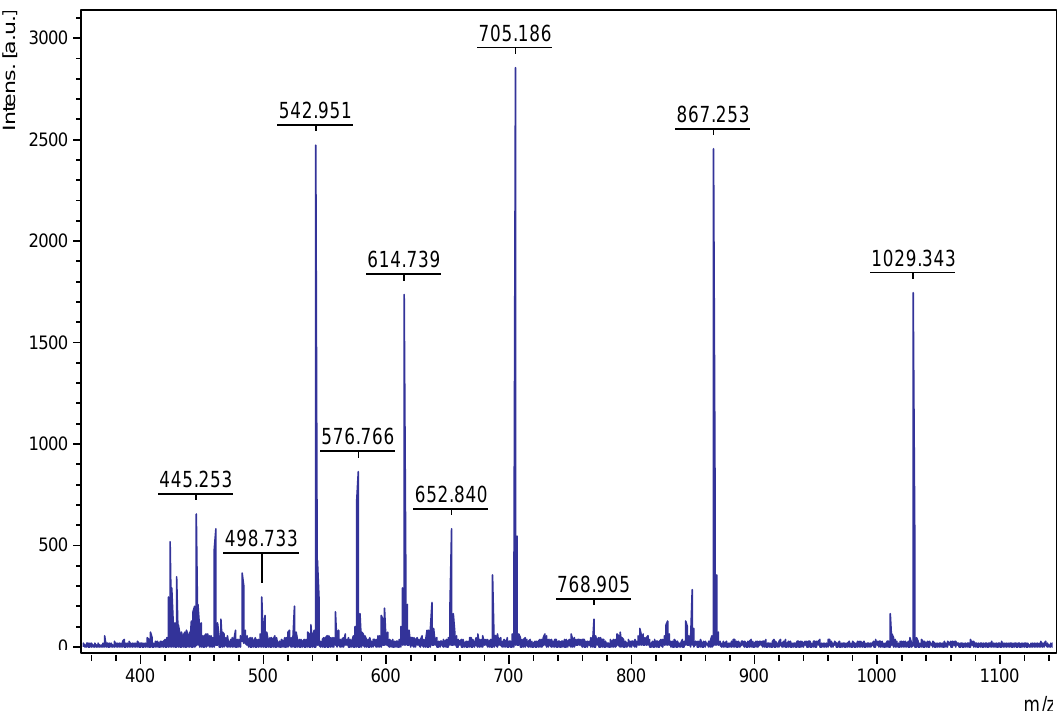
Figure 4. MALDI-TOF MS analysis of the extract from common horsetail ( E. arvense ). Intens. [a.u.]—intensity of m/z signal, absorption units.